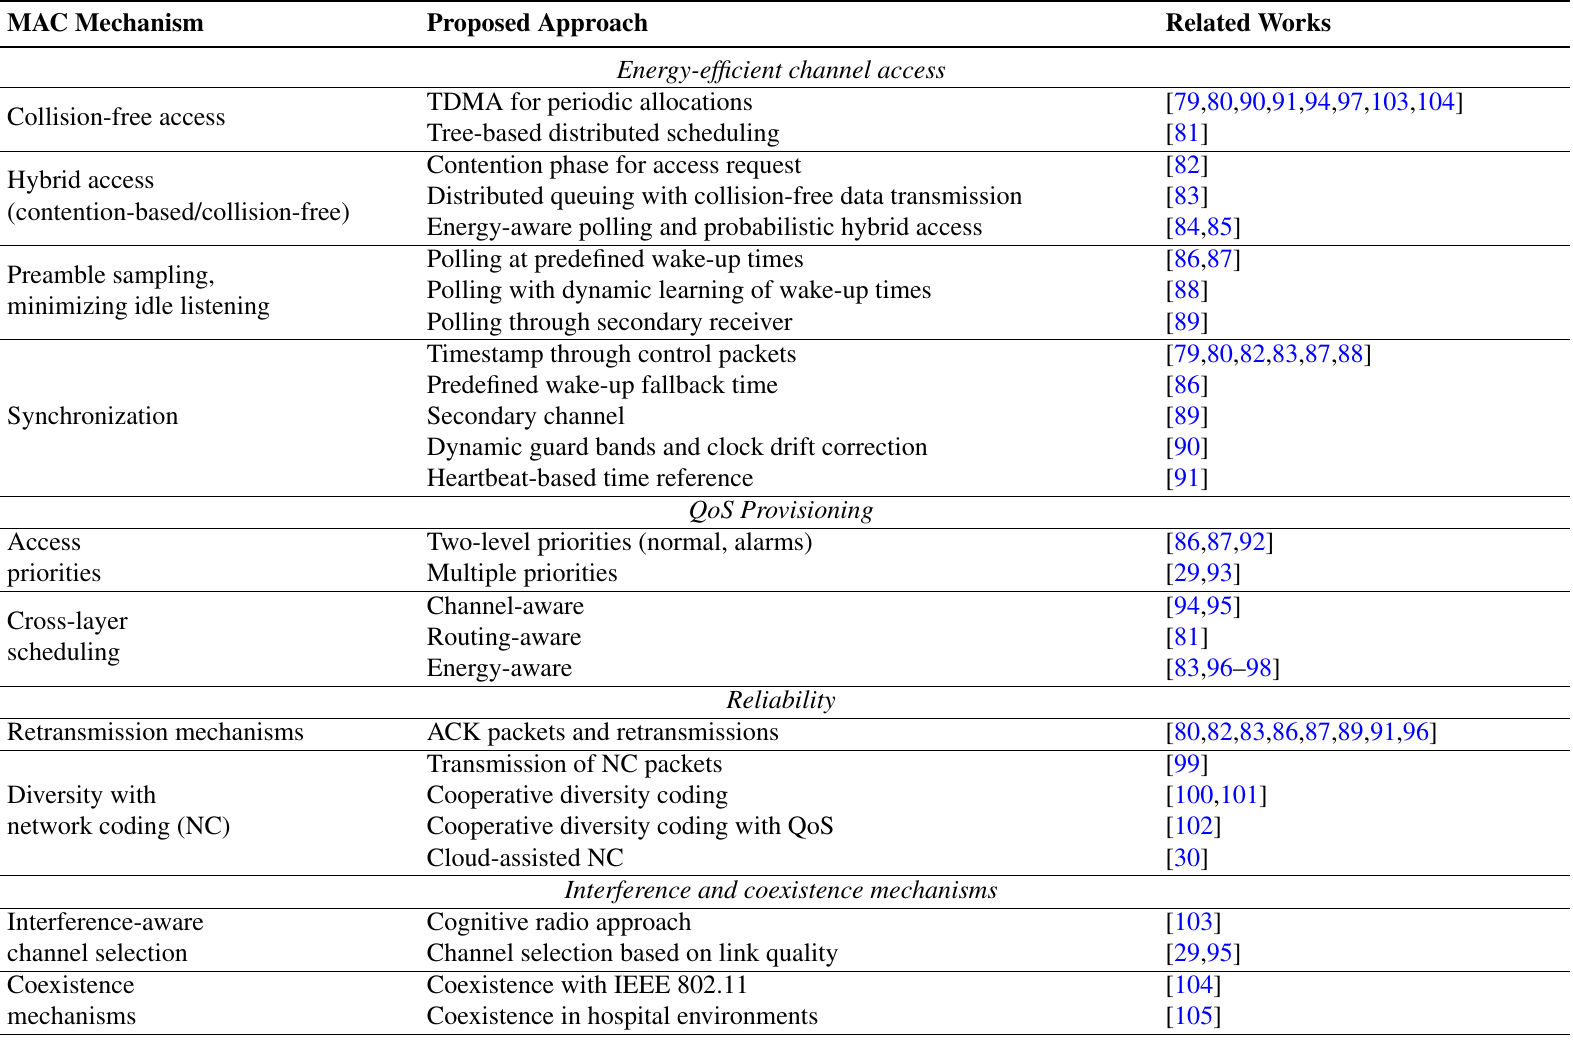
Table 4. Overview of Medium Access Control (MAC) layer mechanisms for Wireless Body Area Networks